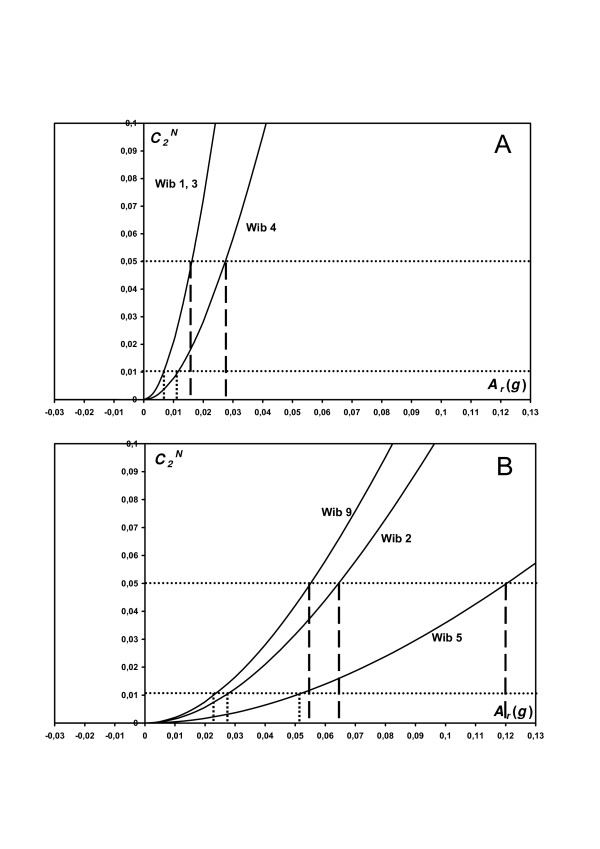
C2N as a function of the relative measure of gene association Ar(g) computed for different multilocus-genotypes (MLG) of P. avium in the stand of Wibbecke. The critical values of the relative measure of gene association Ar(g) for C2N = ε (= 0.05 and 0.01) are plotted; A: MLGs of Wibbecke, for which a 'Type one error' was detected; B: Three of the 13 MLGs of Wibbecke, which were identical also for the additionally used markers (no 'Type one error' detected)